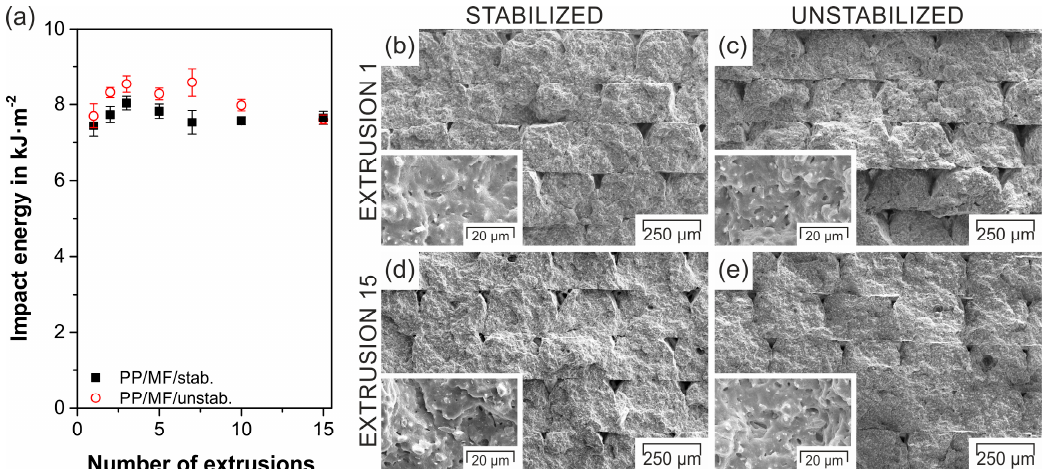
Figure 4. Impact energy of notched Charpy specimens produced by FFF as a function of the number of extrusions for both composites ( a ); and scanning electron microscopy images of the impact fracture surfaces of PP/MF/stab./E-1 ( b ), PP/MF/unstab./E-1 ( c ), PP/MF/stab./E-15 ( d ), and PP/MF/unstab./E-15 ( e ).